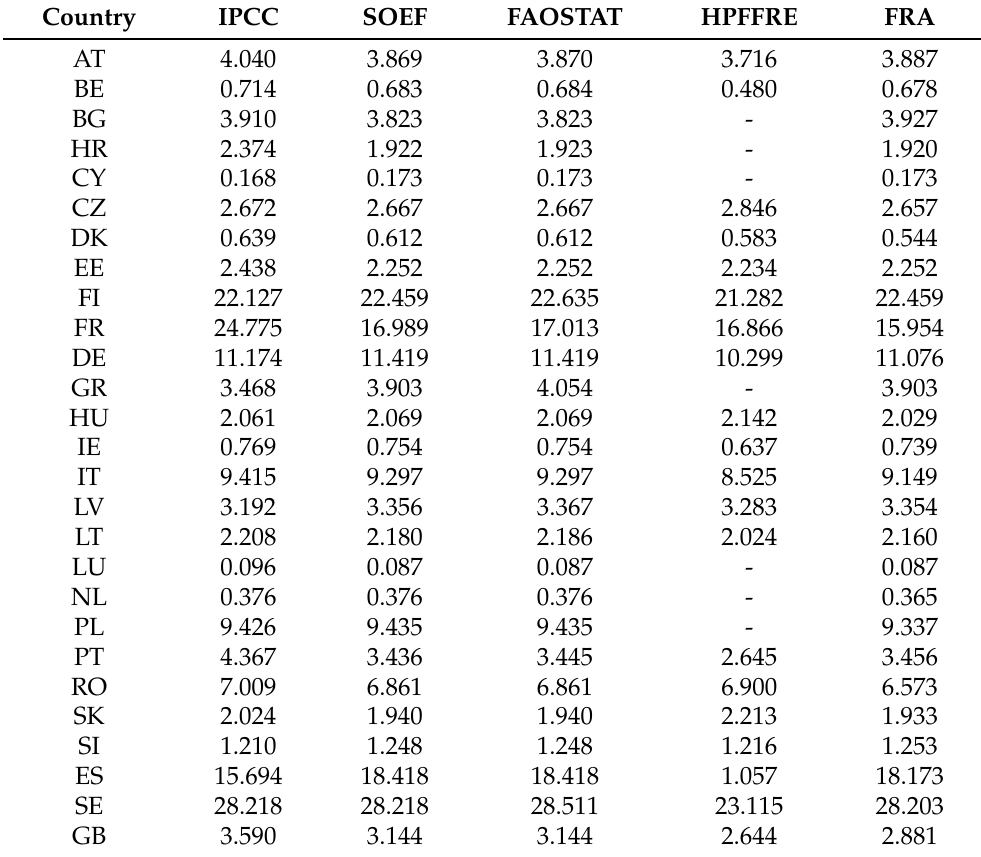
Table A2. Maximum forest area in million of hectares (at any year) for each country by sources.